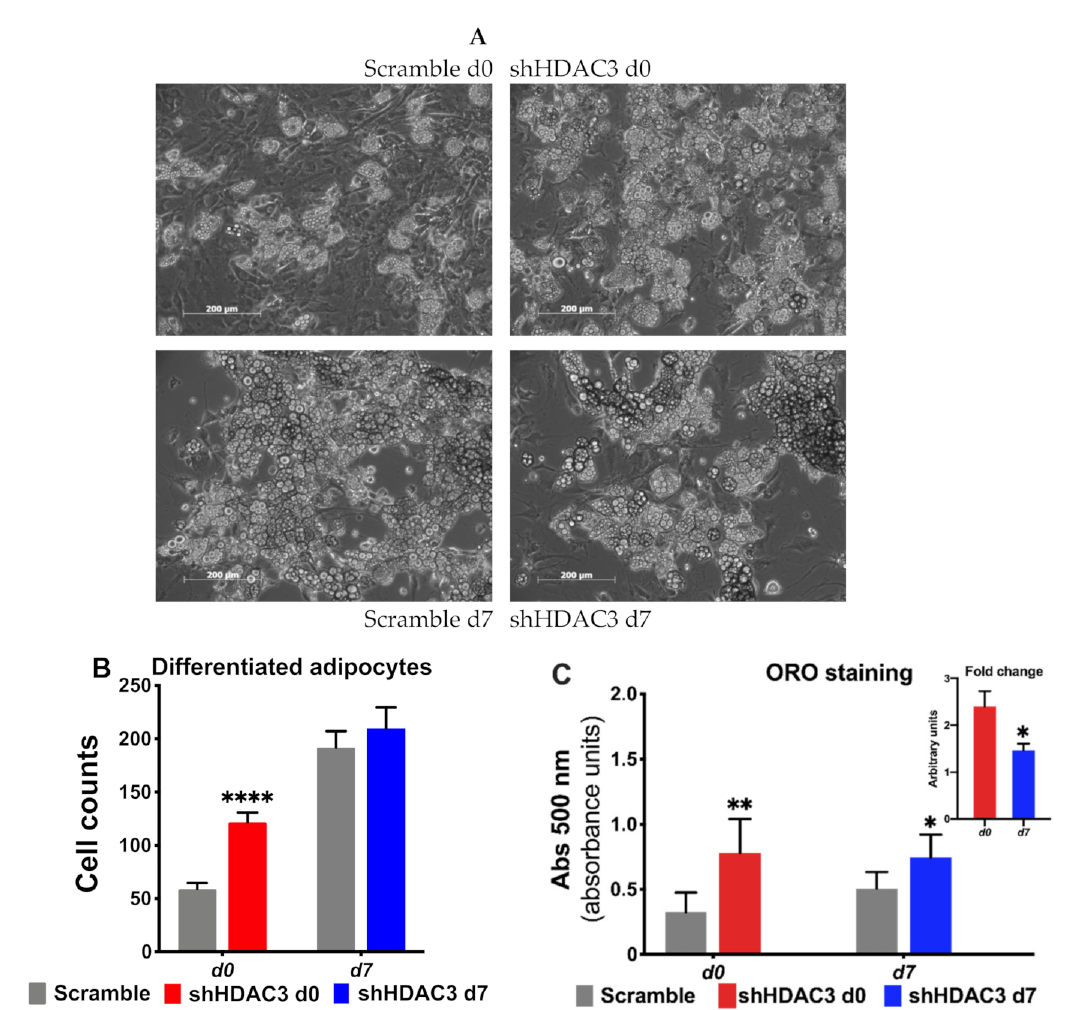
Figure 4. Early silencing of HDAC3 increases the number of differentiated adipocytes. ( A ) Representative images of C3H/10T1/2 MSCs with HDAC3 silencing vs. scramble controls at day 0 or day 7 of differentiation. ( B ) Quantification of mature adipocytes with HDAC3 silencing at day 0 or day 7 post induction of differentiation. Cells silenced at day 0 were harvested at day 9 after induction of differentiation, while cells silenced at day 7 were harvested at day 11 after induction of differentiation. Statistical analysis was performed with GraphPad PRISM using unpaired Student’s t -test, **** p < 0.0001 ( n ≥ 8 counted fields/condition). ( C ) Oil Red O (ORO) staining to quantify lipid content in response to HDAC3 silencing. Inset shows the different fold change of lipid content induced when HDAC3 was silenced at d0 vs. d7 post induction of differentiation. Statistical analysis was performed with GraphPad PRISM using unpaired Student’s t -test, * p < 0.05 and ** p < 0.01 ( n =